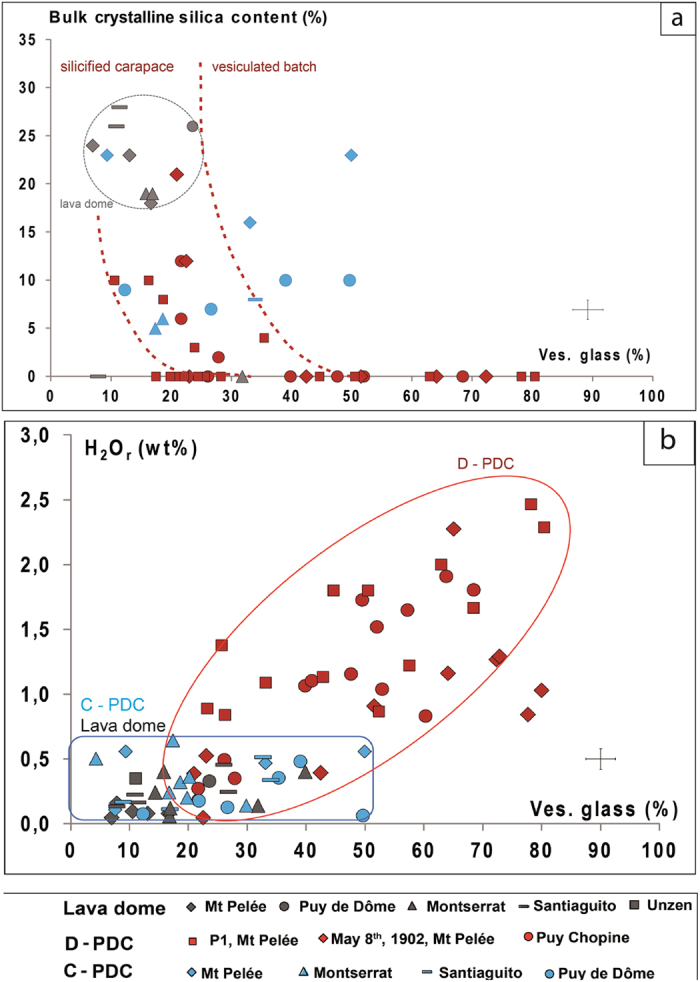
Bulk crystalline silica (cristobalite) and Residual H2O content (H2Or) of samples from lava domes and Pyroclastic Density Current (PDC) deposits, as a function of glass vesicularity (in volume %).Bulk rock vesicularity and H2O content are corrected from phenocryst contents to refer to melt, entitled respectively glass vesicularity and residual H2O content (H2Or) (see methodology). (a) Cristobalite content vs vesicularity glass. Cristobalite contents are expressed in area % and measured by chemical mapping (see methodology). Lava domes. Samples are taken on the different lava domes: Montagne Pelée, Puy de Dôme, Soufrière Hills, Montserrat, Santiaguito. They display a low vesicularity and have the highest content of cristobalite (18–28%). C-PDCs. Clasts have a vesicularity from 10 to 50% and are cristobalite-rich with mean cristobalite contents up to ~23% for Montagne Pelée, and ~5–10% for Puy de Dôme, Montserrat and Santiaguito. The cristobalite content is independent of the glass vesicularity. D-PDCs. D-PDC samples display a large range of clast types. Beyond a glass vesicularity threshold value of ~40% no or low cristobalite is observed in clasts. Below this threshold, some clasts don’t contain cristobalite whereas others show a negative correlation between vesicularity and cristobalite with a maximum value of 20% (Montagne Pelée). Clasts with glass vesicularities below the threshold, with or without cristobalite, may represent the silicified and rigid lava dome carapace whereas clasts with glass vesicularities above that threshold may represent the inner, less-degassed and vesiculated magma. (b) Residual H2O content (H2Or) vs. glass vesicularity. Blue square domain: lava dome and C-PDC samples. Lava dome samples: H2Or < 0.4 wt% and V < 40%. C-PDC clasts: H2Or < 0.7 wt% and V < 50%. Red domain: D-PDC clasts. H2Or ranges from 0.2 to 2.5 wt% and glass vesicularity from 10 to 80%. The pre-eruptive H2O contents measured on melt inclusions for all these eruptions are significantly higher (>5 wt%16212223).